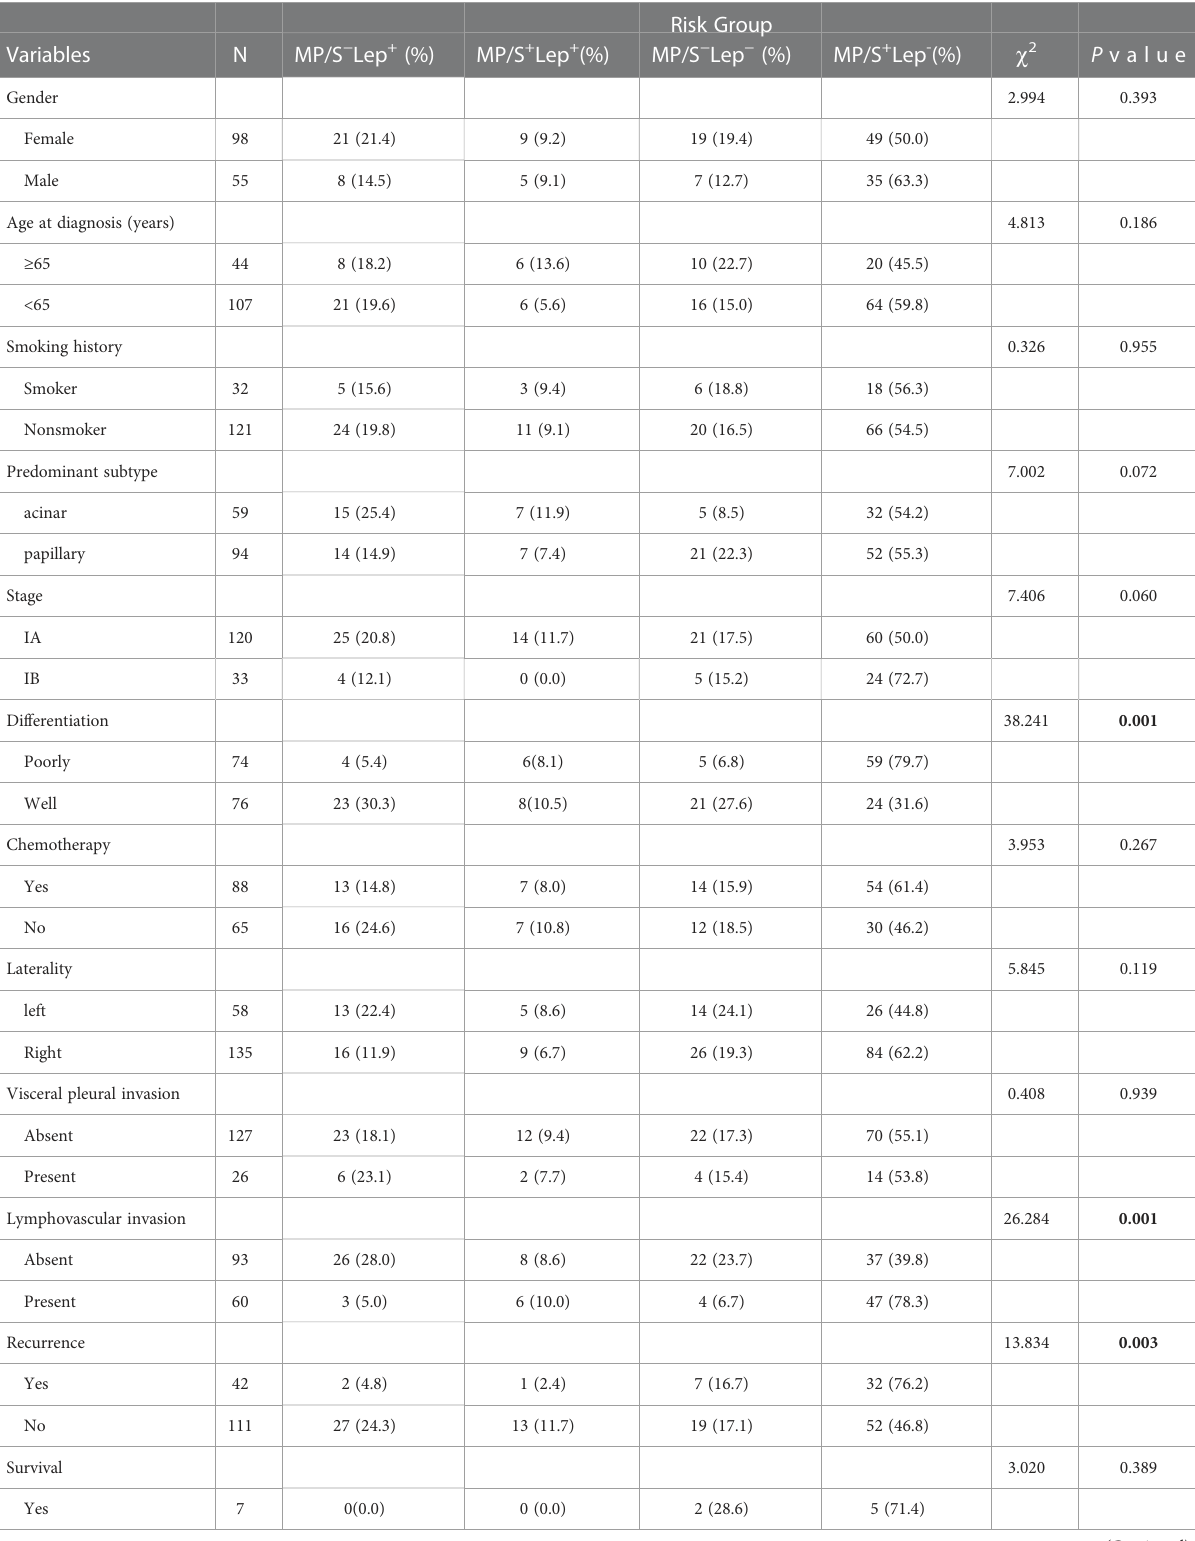
TABLE 2 Relationships between clinicopathological characteristics and the presence of lepidic and micropapillary/solid pathological patterns as minor components in patients with stage I lung